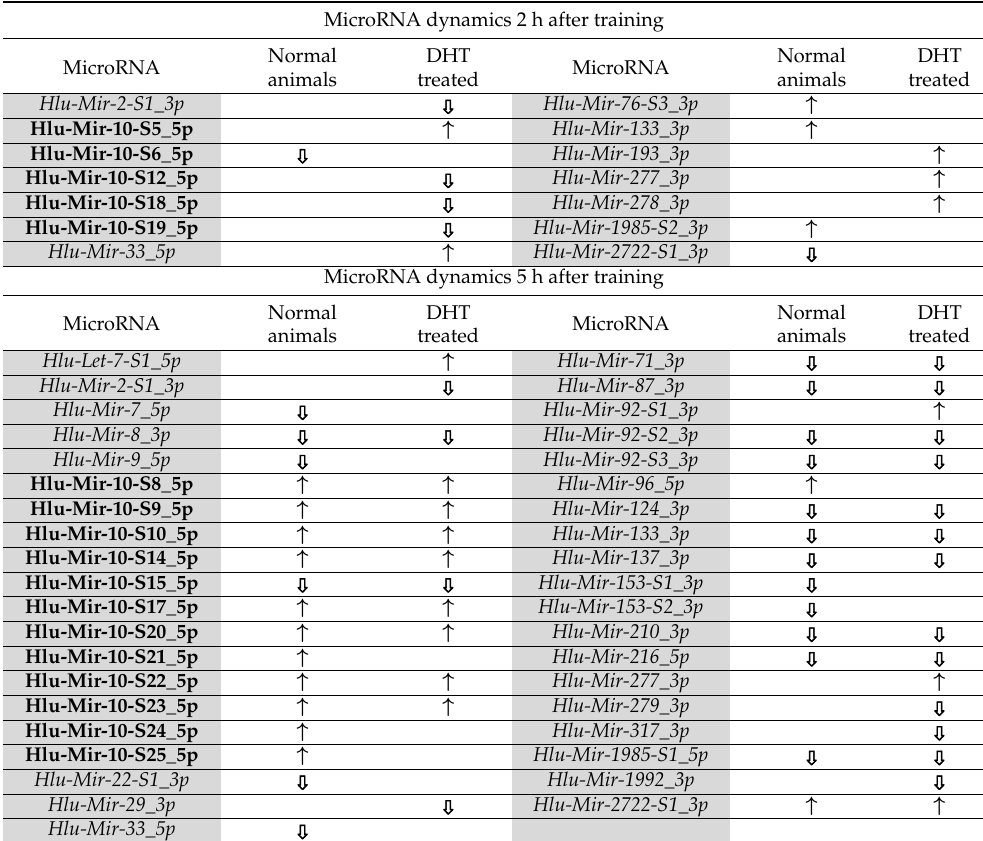
Table 2. Food aversion learning is associated with time-dependent changes in microRNA profiles in the CNS of H. lucorum compared to naive animals. The damage of serotoninergic transmission by DHT impairs the learning and shifts dynamics of several microRNAs 2 h and 5 h after training. ⇩ - downregulation, ↑ -upregulation.